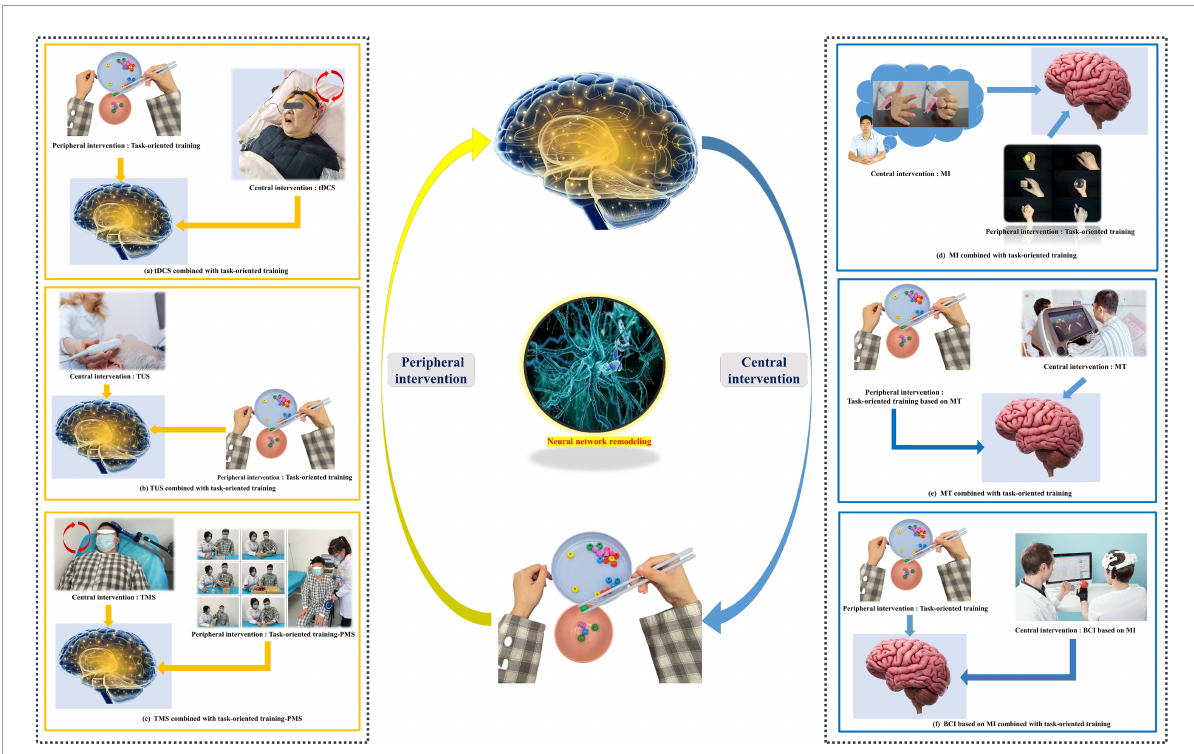
FIGURE3 Common paradigms of the “closed-loop” rehabilitation strategy. (a) tDCS combined with task-oriented training. (b) TUS combined with task-oriented training. (c) TMS combined with task-oriented training-PMS. (d) MI combined with task-oriented training. (e) MT combined with task-oriented training. (f) BCI based on MI combined with task-oriented training. (Written informed consent was obtained from the individual for the publication of the